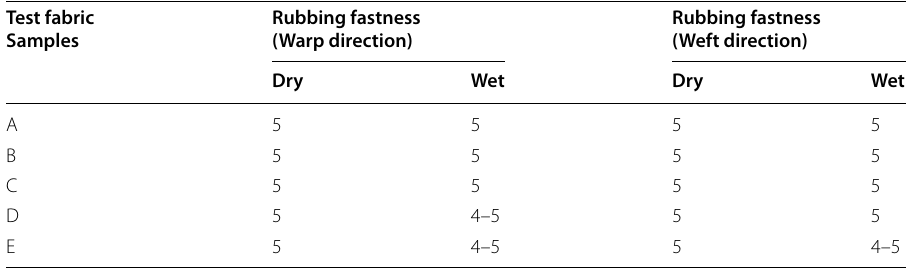
Table 5 Colorfastness to rubbing (dry and wet) of henna dyed polyester fabric samples Test fabric